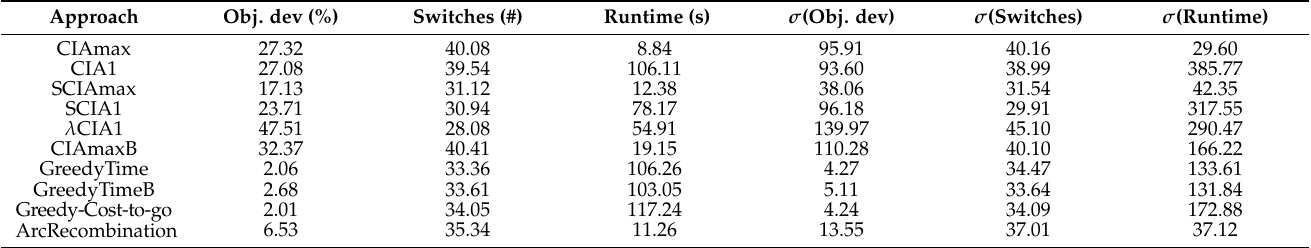
Table A1. Comparison of mean values and standard deviation ( σ ) of objective deviation, switching values, and runtime for different approaches. Objective deviation is given in percentages compared to relaxed objective, and runtime describes elapsed real time.